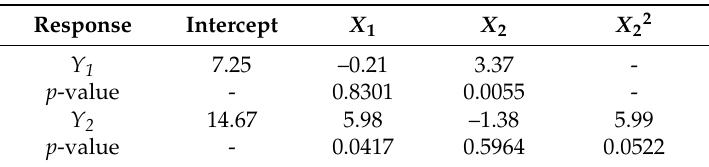
Figure 2. Contour plot showing the effects of kafirin and prednisolone quantities (mg) on ( Y 2 ) loading efficiency (%). The numbers in the small squares refer to the response value. Table 3 . Contributions of independent factors to the mathematical model expressed as coefficients with p -values.